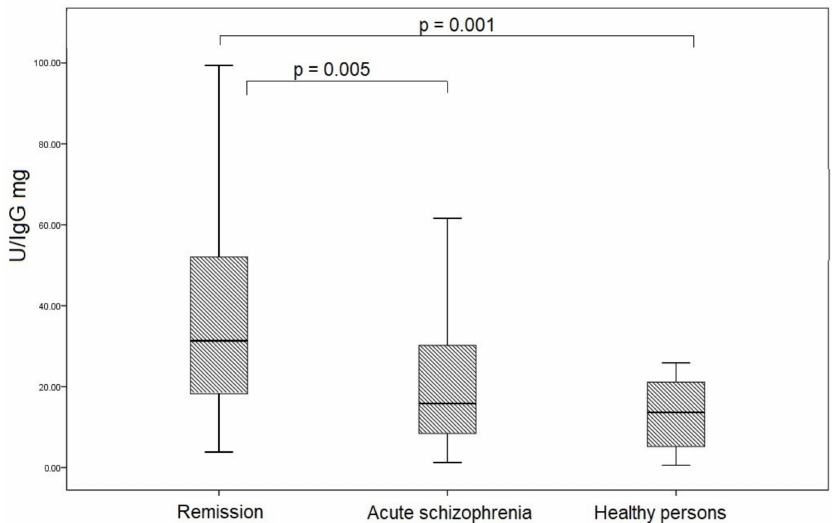
Figure 4. SOD activity of IgG in patients with acute schizophrenia, remission, and healthy persons. Note: To calculate the specific activity, the measured amount of diformazan was used in terms of IgG mg. U corresponds to the amount of enzyme that catalyzes the conversion of 1 µ mol of substrate in 1 min at +25 ◦ C.